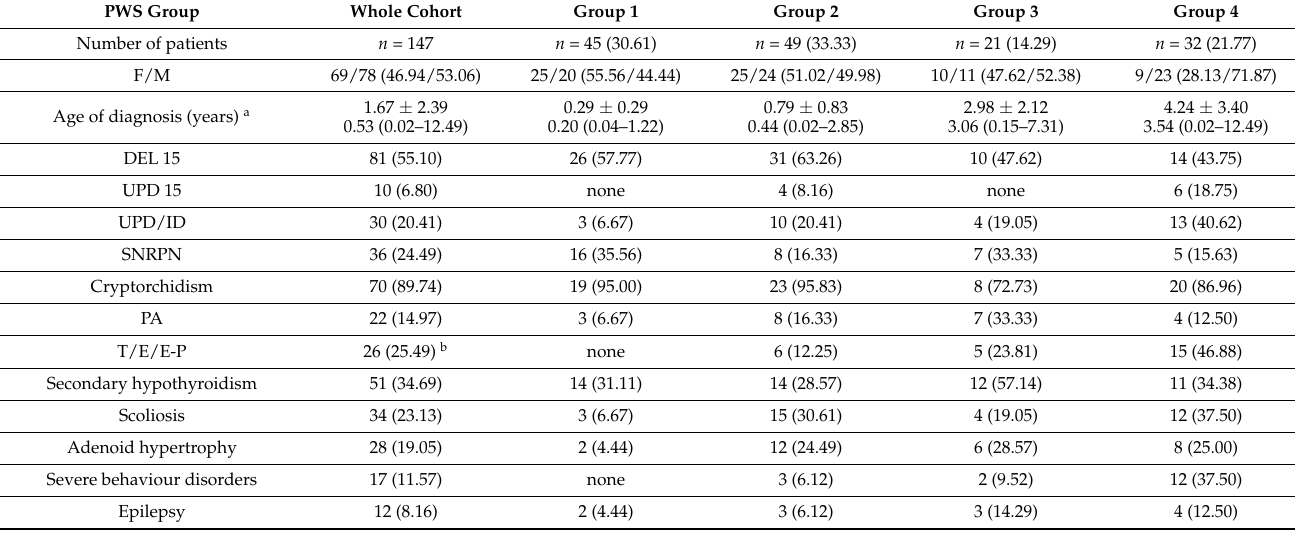
Table 1. Type of genetic diagnosis and clinical characteristics of patients with PWS, number of patients (percentage), mean value ± standard deviation scores (SDS) and median (minimal–maximal value) for the age of